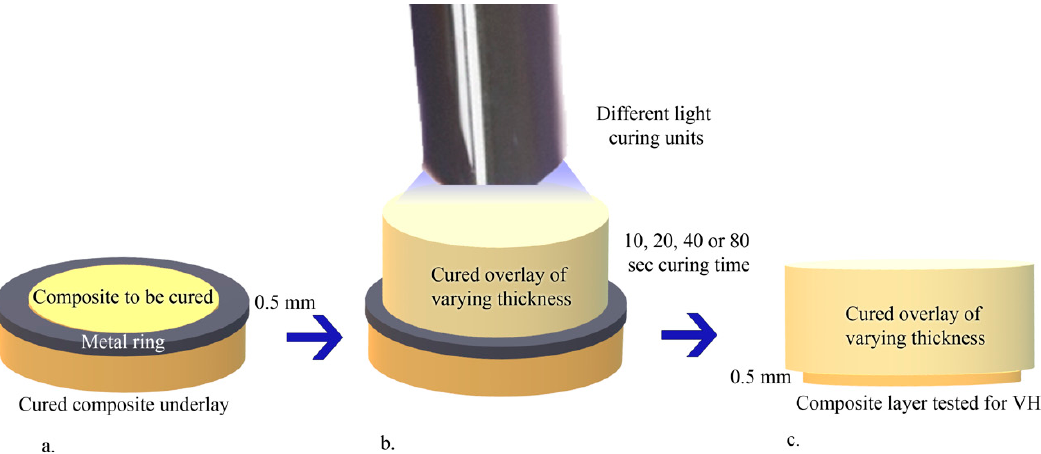
Figure 1. Specimen preparation ( a , b ) and final specimen shape ( c ). The 0.5 mm-thick resin layer was subjected to the Vickers Hardness evaluation.